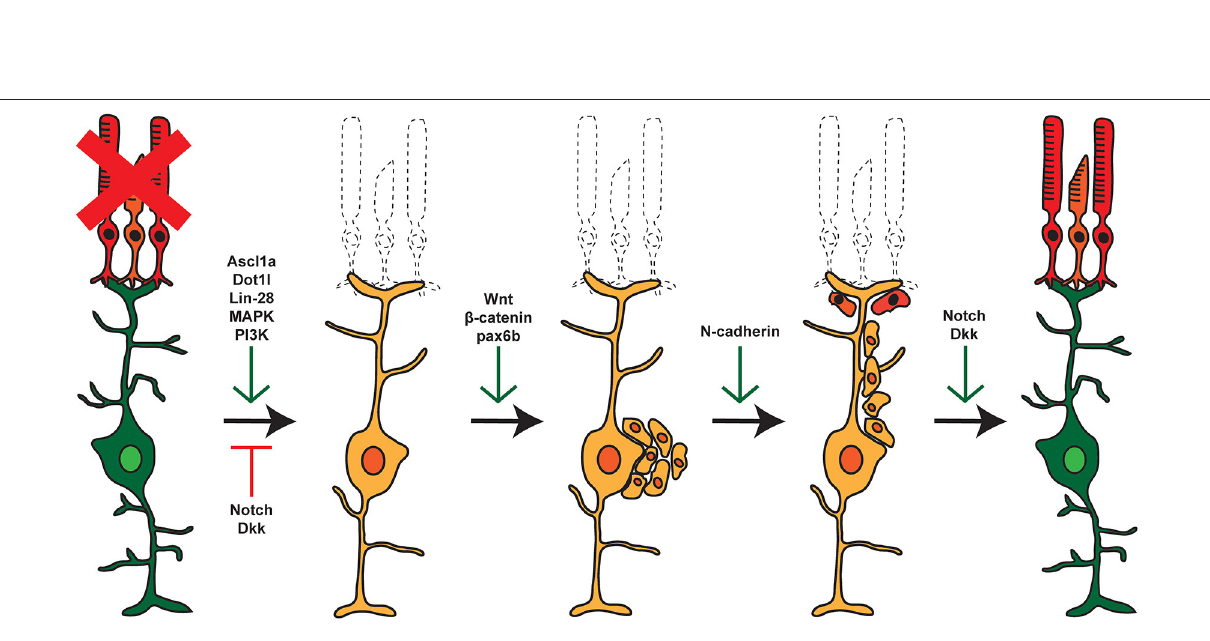
Frontiers in Cell and Developmental Biology |